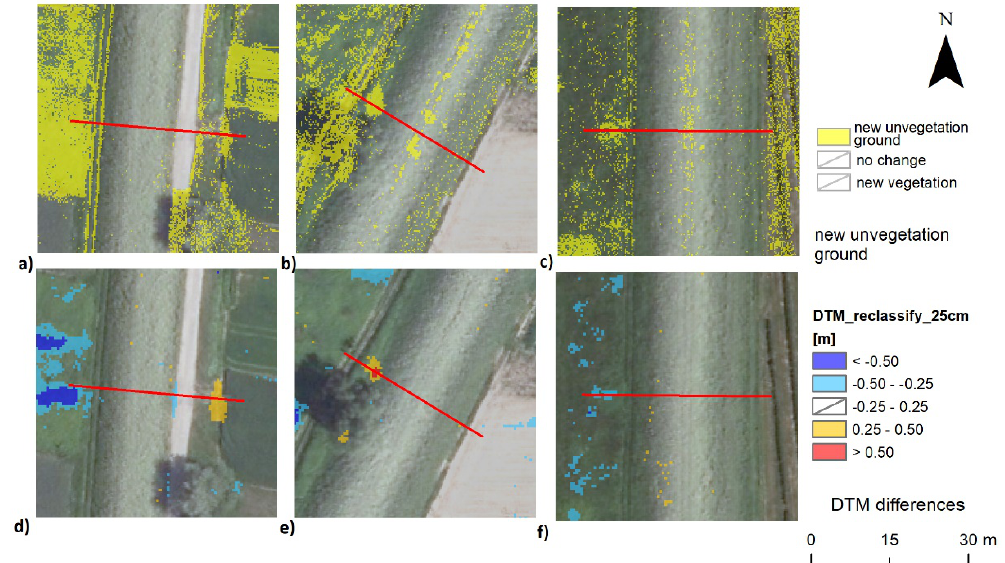
Figure 9. Profile example presented on the new unvegetation ground class (a), (b), (c) and the DTM differences (d), (e), (f) resulting in potential danger for the levee (landslide) for three examples.